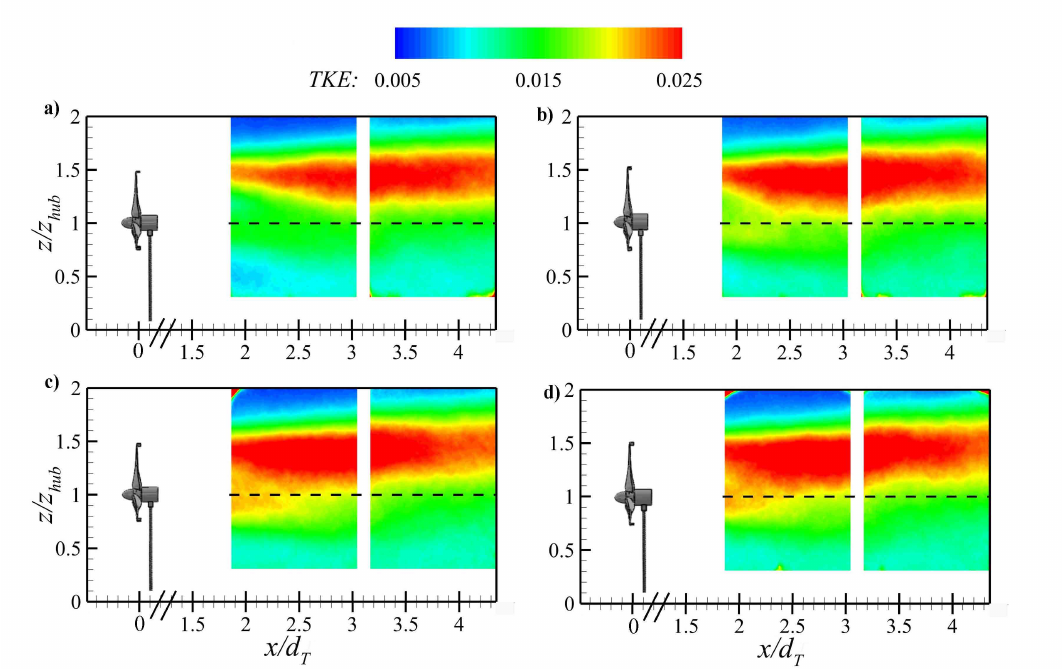
Figure 9. Distribution of turbulence kinetic energy, TKE =< u ′ 2 + w ′ 2 > / 2 U 2